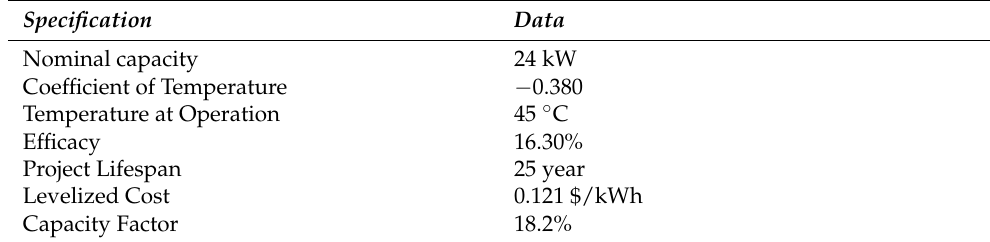
Table 2. Technical specification of PV system.